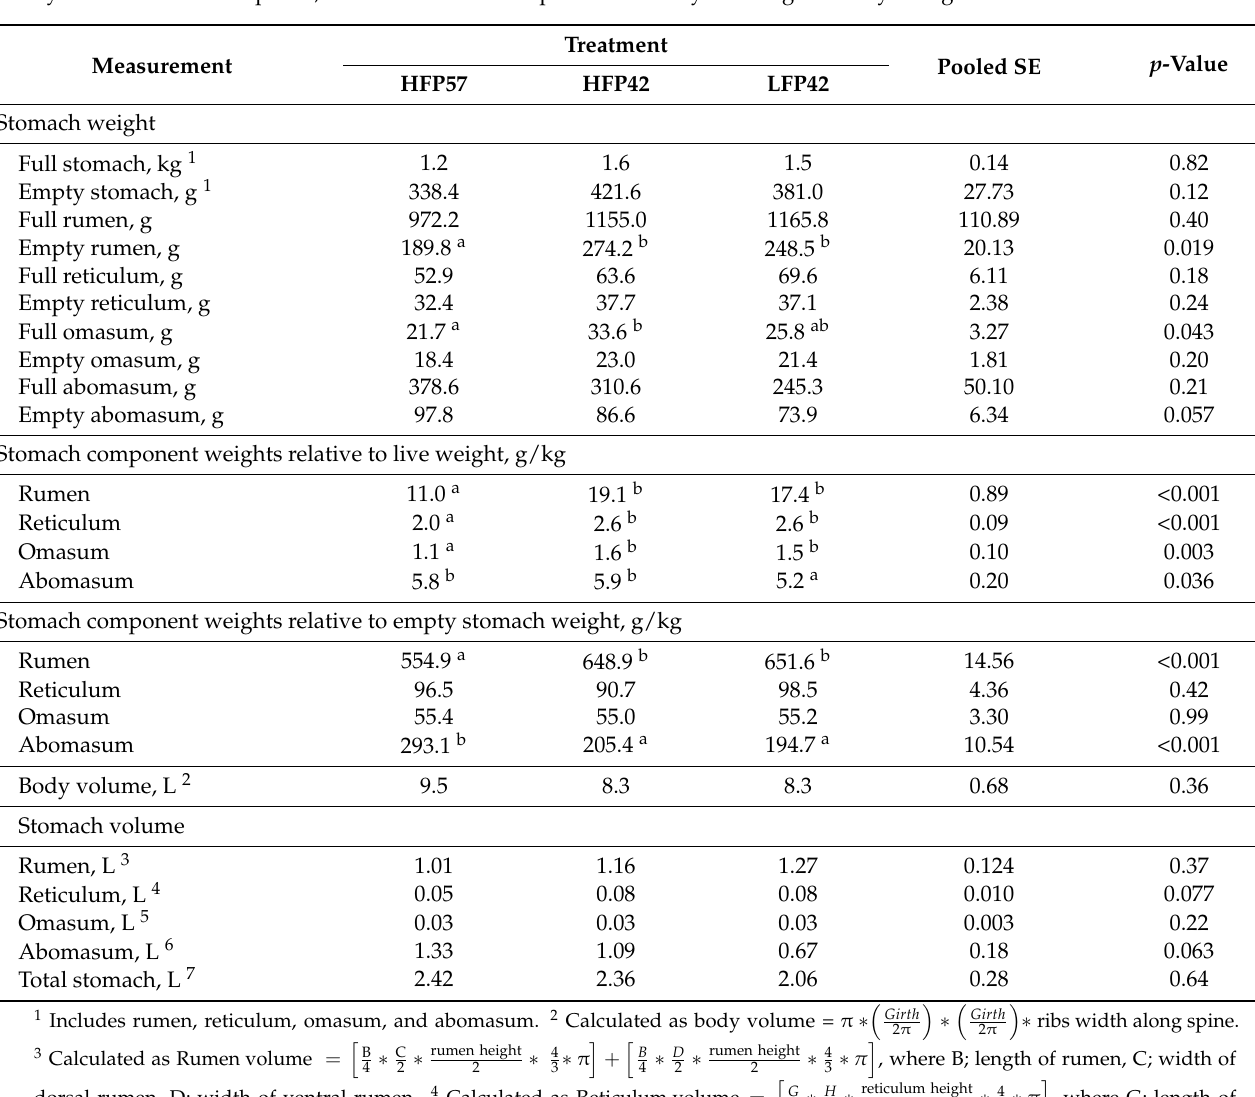
Table 6. Stomach parameters of lambs reared artificially using three different rearing regimens: HFP57, commercial milk replacer, high fibre concentrate pellets, and milk feeding to 57 days of age; HFP42, commercial milk replacer, high fibre concentrate pellets and early weaning at 42 days of age; LFP42, high protein milk replacer from 2–16 days of age followed by commercial milk replacer, low fibre concentrate pellets and early weaning at 42 days of